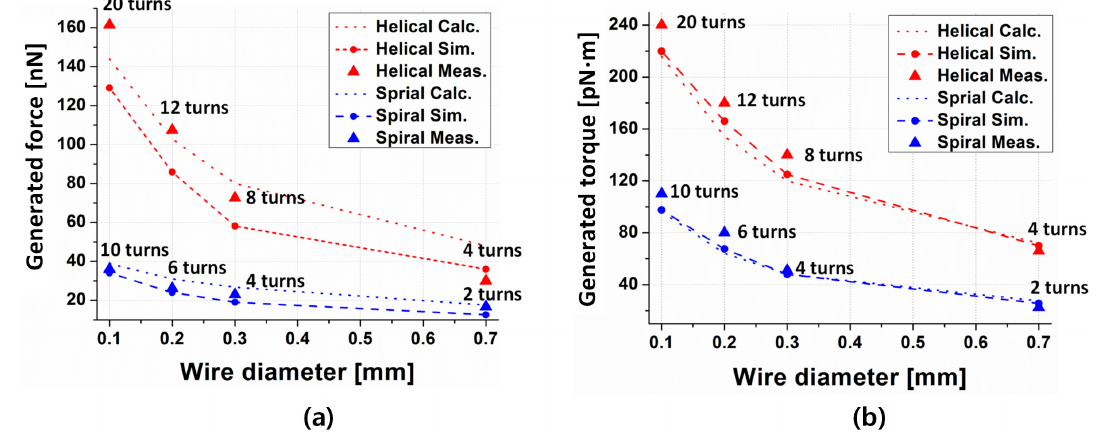
Figure 8. Analytical calculation, numerical simulation and measurement results of propulsion force ( a ) and torque ( b ) in relation to the wire diameter with a 3 mm load coil.